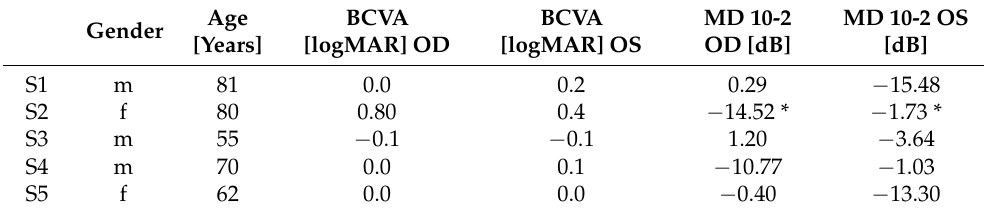
Table 1. Demographic data of the